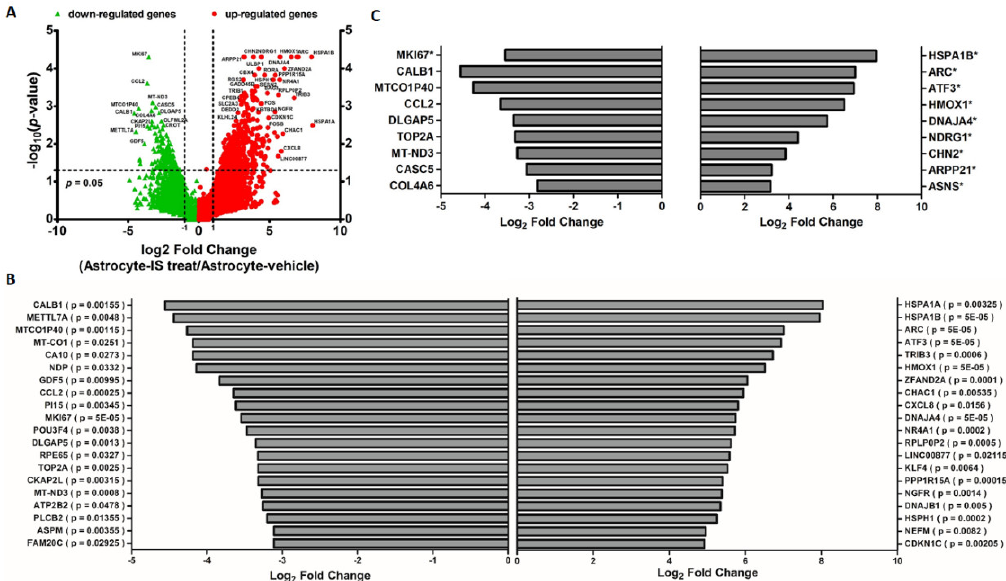
Figure 3. Display of differential expression patterns of IS-treated and vehicle-treated human astrocyte from deep sequencing. ( A ) Volcano plot of the RNA sequencing result of differential gene expression in IS and vehicle-treated astrocyte. The x-axis indicates the logarithm to the base 2 of expression fold-change (astrocyte-IS treat/Astrocyte-vehicle), and the y-axis indicates the negative logarithm to the base 10 of the p -values. Red circular marks represent upregulated genes in the Astrocyte-IS treat group, and green triangular marks represent downregulated genes in the Astrocyte-IS treat group. Vertical lines reflect the filtering thresholds of 2.0-fold-change, and horizontal line reflect filtering threshold of p -value = 0.05. A total of 437 significantly upregulated and 191 significantly downregulated genes in IS-treated astrocytes can be identified. ( B ) Bar graphs display the top 20 upregulated and 20 downregulated genes in IS-treated astrocytes with p -value < 0.05. ( C ) Bar graphs display the upregulated and downregulated genes in IS-treated astrocytes with a false discovery rate (FDR) adjusted p -value (* indicates FDR-adjusted p -value < 0.05).